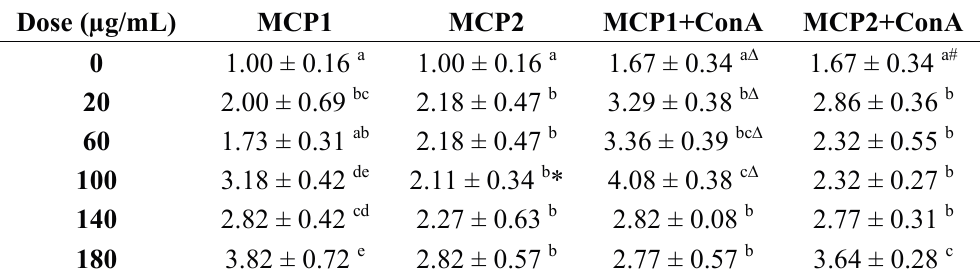
Table 2. Effects of MCP1 and MCP2 on the proliferation of splenic lymphocytes in vitro